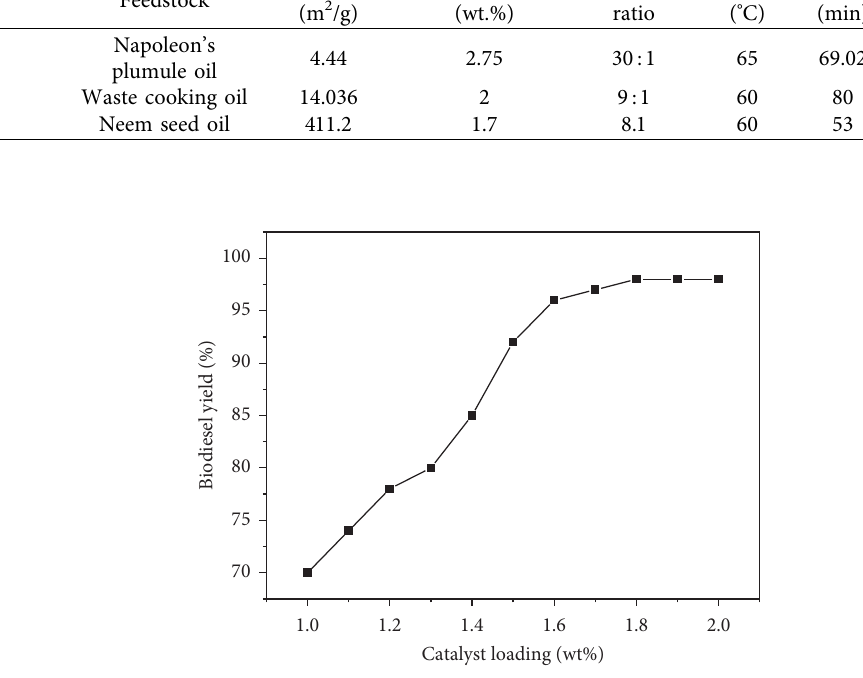
Figure 5: Effect of the amount of catalyst added on the production of